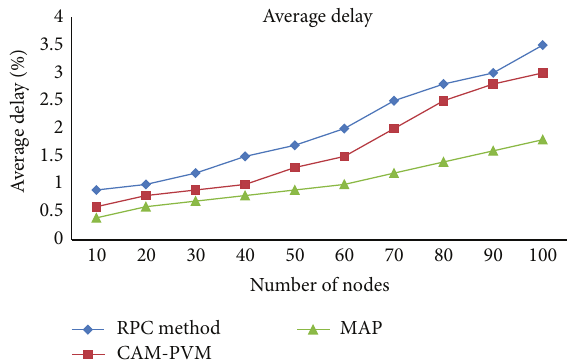
Figure 3: Comparison of average delay of data packet transfer between existing method RPC with CAM-PVM and MAP.